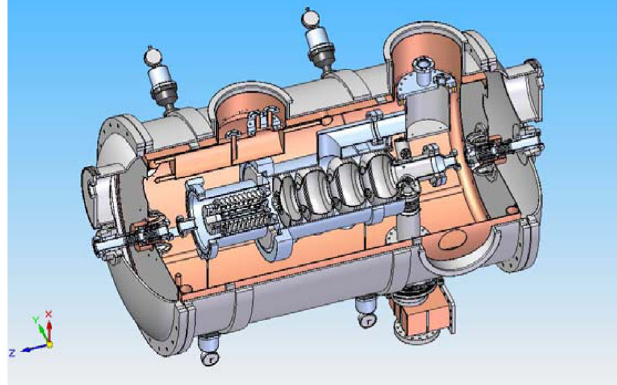
FIG. 1. (Color) Schematic design of 3.5-cell DC-SRF